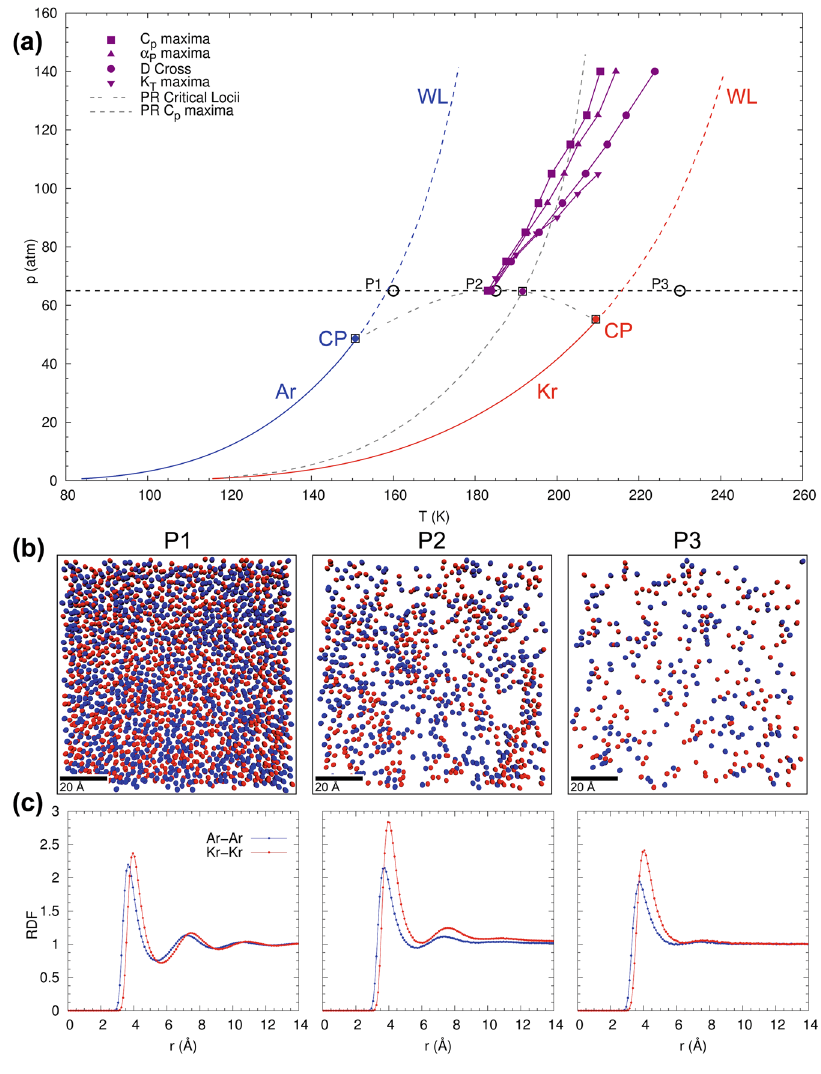
Figure 2. Supercritical state space and molecular structure of equimolar Ar/Kr mixture with type-I phase behavior, showing ( a ) projected p - T state plane with locations of the maxima of C p , α p , κ T and diffusion coefficient crossovers as obtained from isobaric MD-simulations; ( b ) MD-snapshots of molecular structure and ( c ) radial distribution function at a supercritical pressure of 65 atm and three different temperatures (160 K, 180 K, and 230 K; from left to